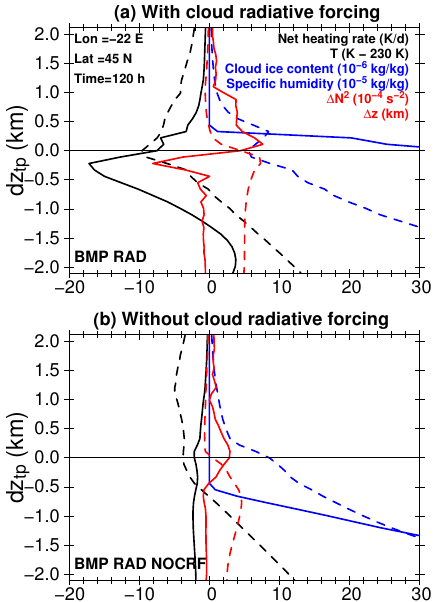
Figure 13. Tropopause-based vertical profiles through an ice cloud along the central latitude at 120h for (a) a simulation with cloud radiative forcing (BMP RAD) and (b) a simulation without cloud radiative forcing (BMP RAD NOCRF). Solid lines show net ra- diative heating (in Kd − 1 , scaled for better comparability, black), cloud-ice content (in 10 − 6 kgkg − 1 , blue), and (cid:49)N 2 (in 10 − 4 s − 2 , red). Dashed lines show temperature (in K – 230K, black), specific humidity (in 10 − 5 kgkg − 1 , blue), and (cid:49)z (in km, red). d z tp is the distance to the height of the thermal tropopause.